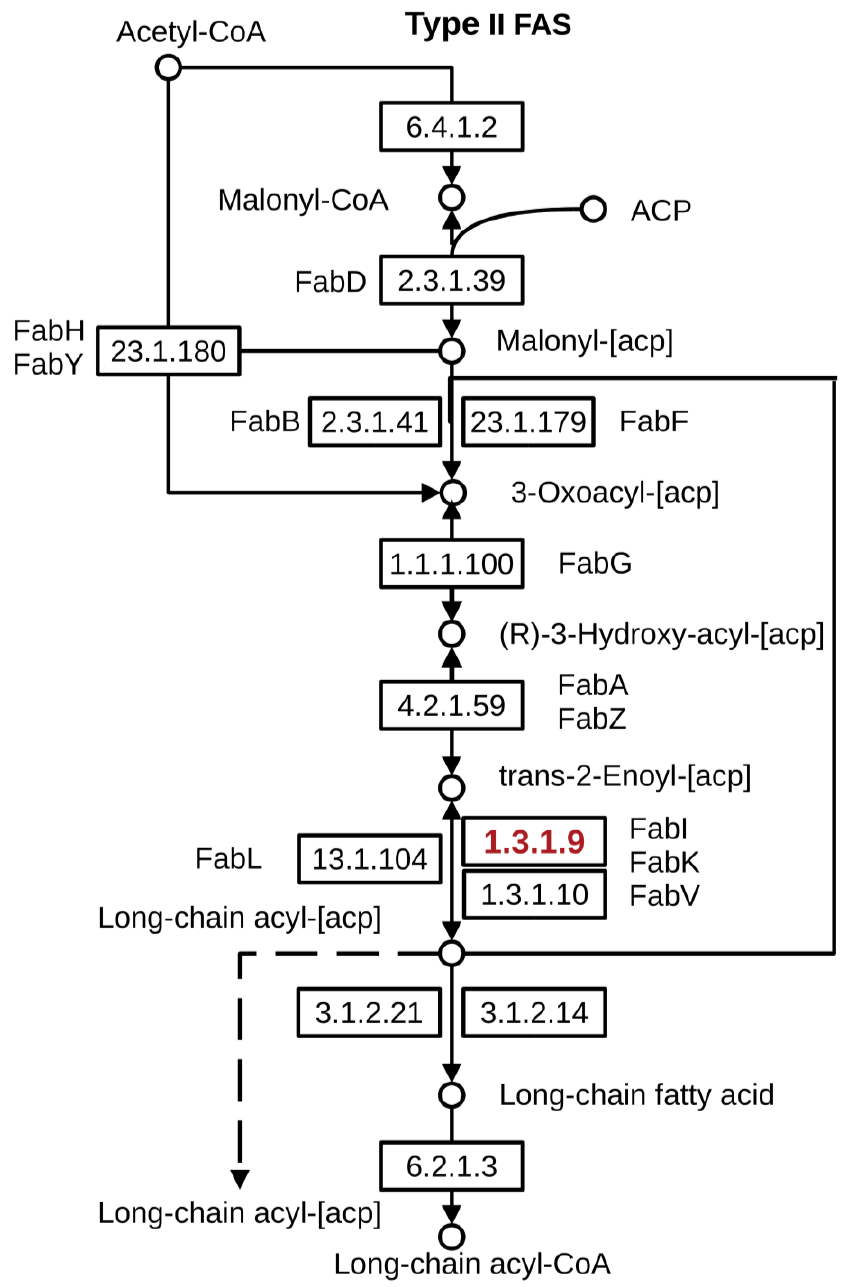
Figure 1. Key role of enzyme FabI (highlighted in red) in A. baumannii and S. aureus fatty acid biosynthesis [15].